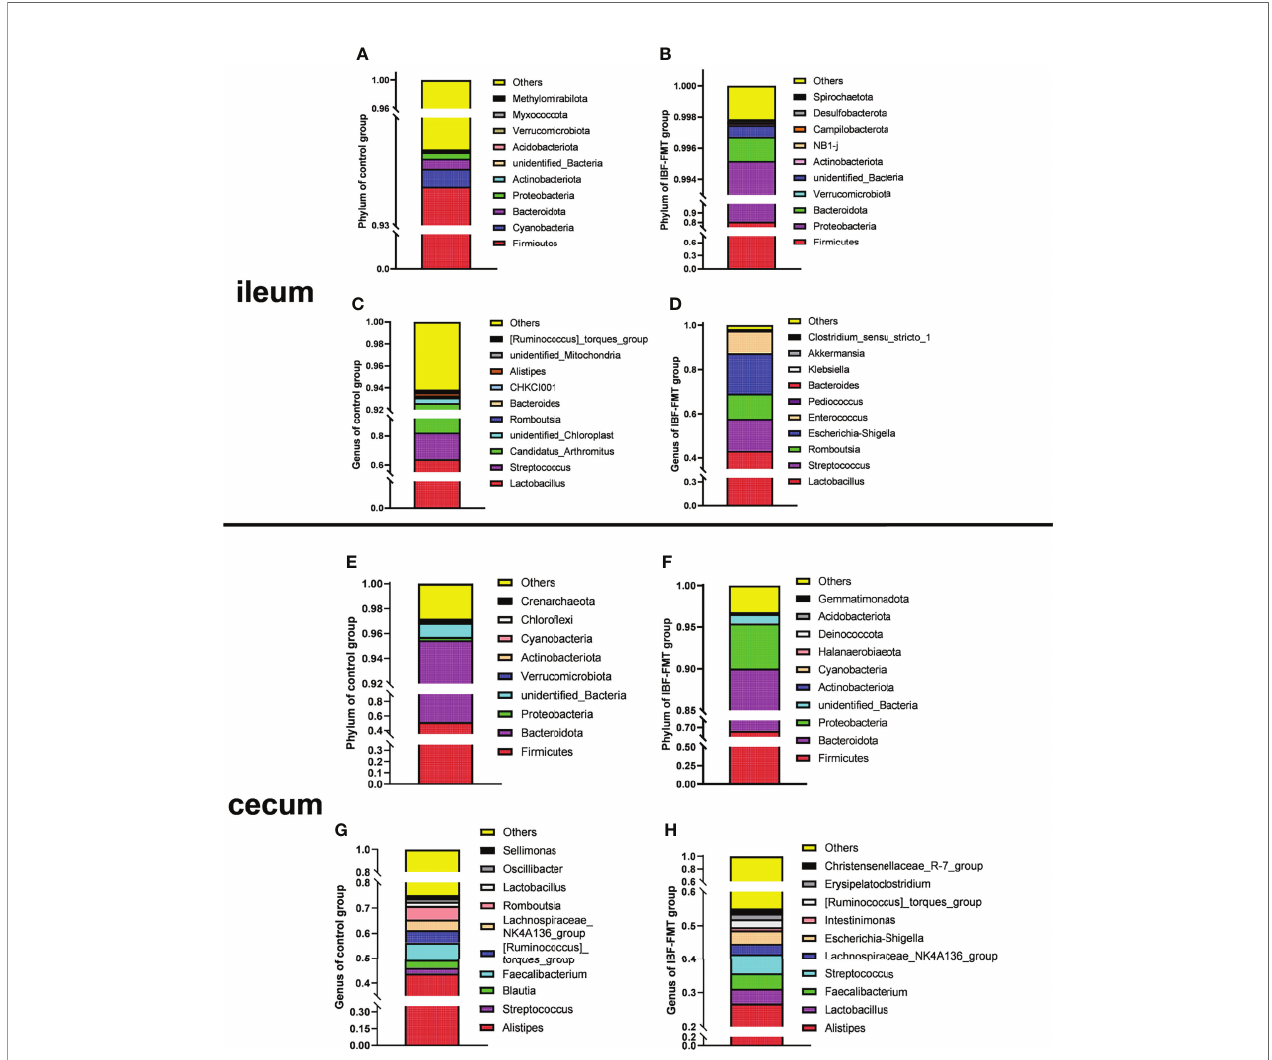
FIGURE 1 | The comparative analysis of intestinal fl ora structure in control and IBF-FMT group. The main bacteria structure at the phylum and genus level in the ileum (n= 9) and cecum (n= 9) of control group were shown in panels (A, C) and panels (E, G) , respectively. Based on the IBF bird model, the whole intestinal fl ora of chickens in the control group were transplanted into the intestine of the chickens of IBF-FMT group, and the main bacteria structure at the phylum and genus level in the ileum (n= 7) and cecum (n= 8) of IBF-FMT group were shown in panels (B, D) and panels (F, H) ,